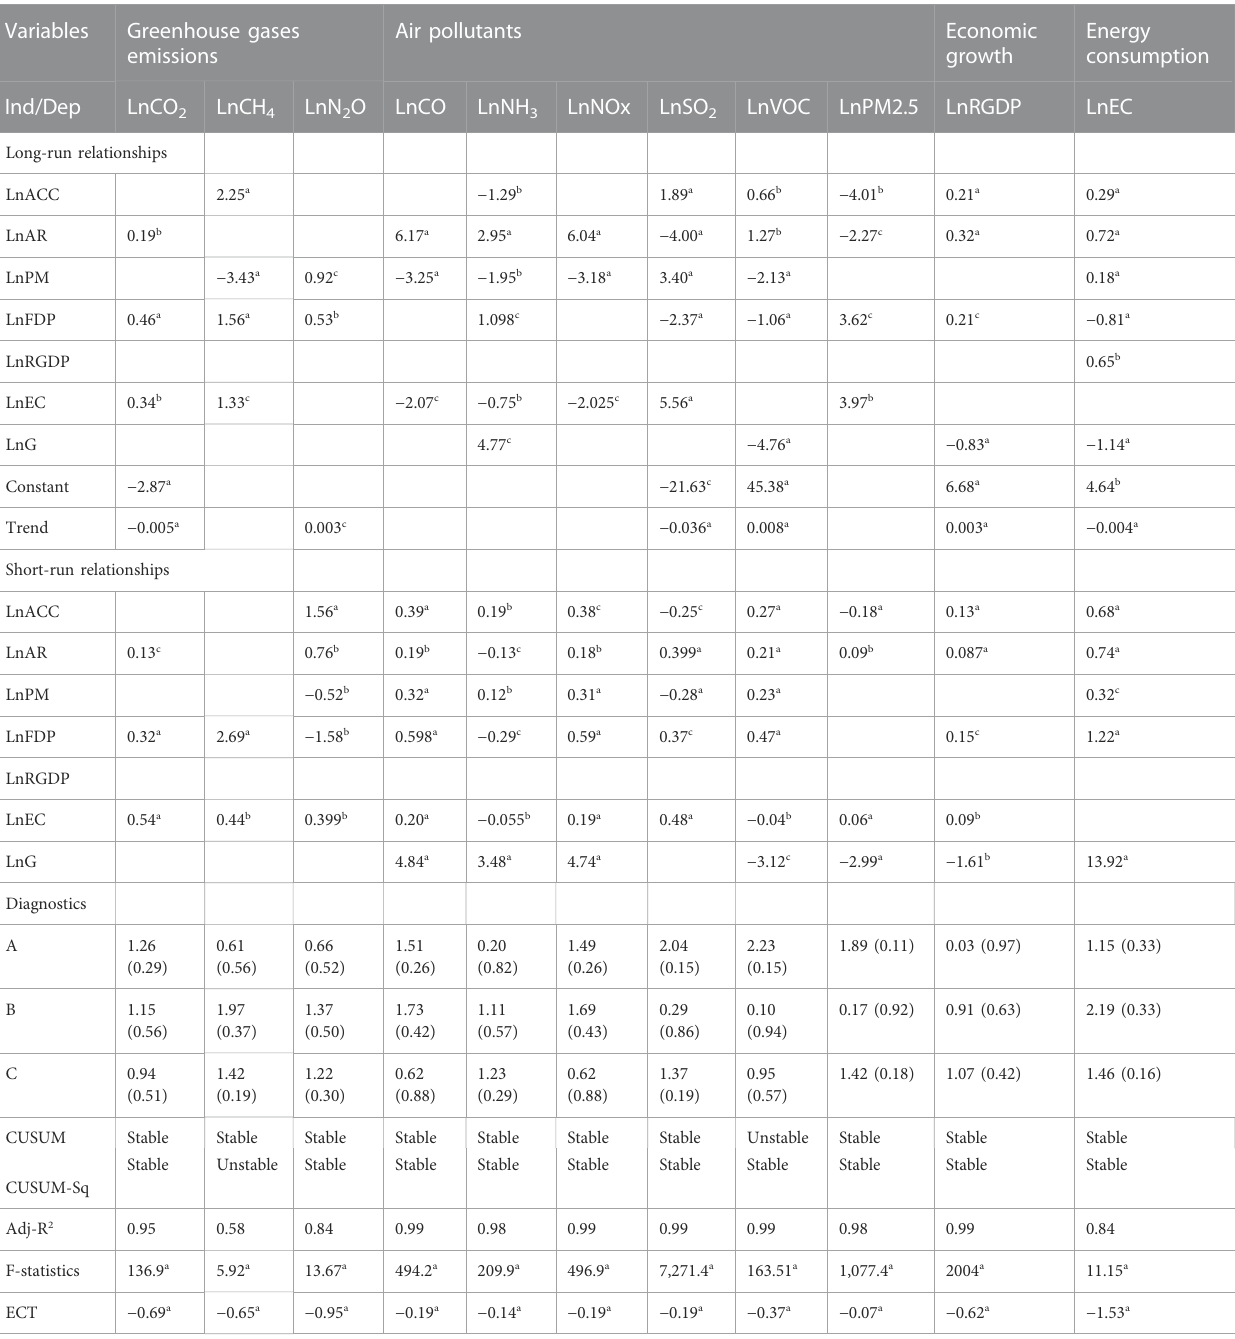
TABLE 5 Entertainment and hospitality subsectors long and short-run dynamics.